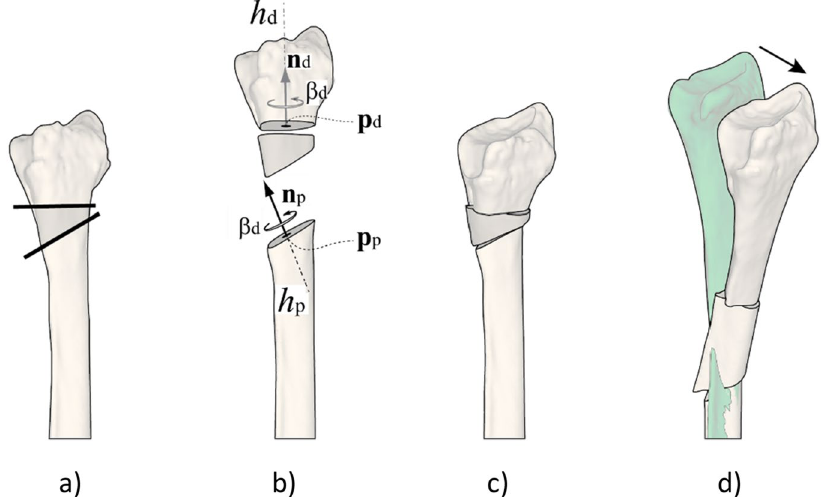
Figure 1. ( a ) Rotational alignment correction of a deformed bone using an oblique double-cut rotation osteotomy. ( b ) The distal segment is rotated over β d about the axis ( h d ) oriented in the direction of the cutting plane normal ( n d ) and a point on the axis ( p d ), being the centroid of the polygon points in the cutting plane. A second axis ( h p ) is defined in the same way using the proximal cutting plane (cutting plane normal n p , point on the axis p p ). The rotated distal segment and the middle segment are considered a single assembly which is rotated about the axis over the angle β p . The exploded view shows applicable parameters. ( c ) Aligned bone segments after rotation. ( d ) In general, a residual translation error may persist (arrow) between the corrected bone and the target bone (green), although rotational alignment is achieved. This translation error depends on the chosen osteotomy parameters, such as the osteotomy plane